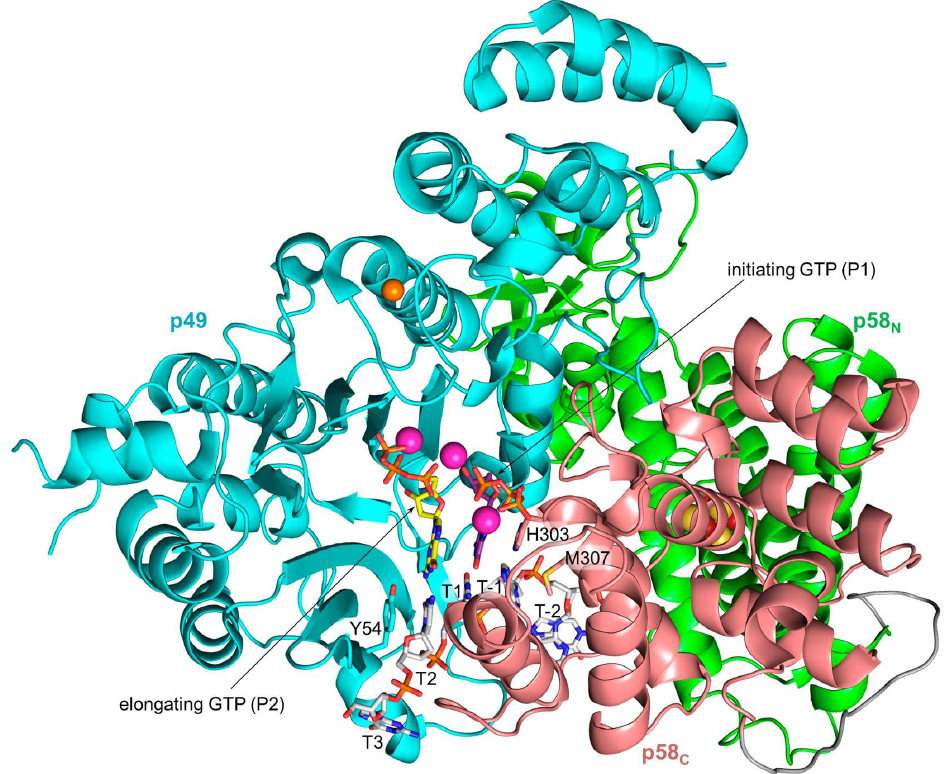
Figure 4. The model of human primase in the initiation complex with a DNA template and two GTP molecules. The linker between p58 N and p58 C colored gray is shown for reference purposes only. The carbons of the DNA template, initiating GTP, and elongating GTP are colored gray, purple, and yellow, respectively. The atoms of zinc, magnesium, iron, and sulfur are represented as spheres and colored orange, magenta, red, and yellow, respectively.